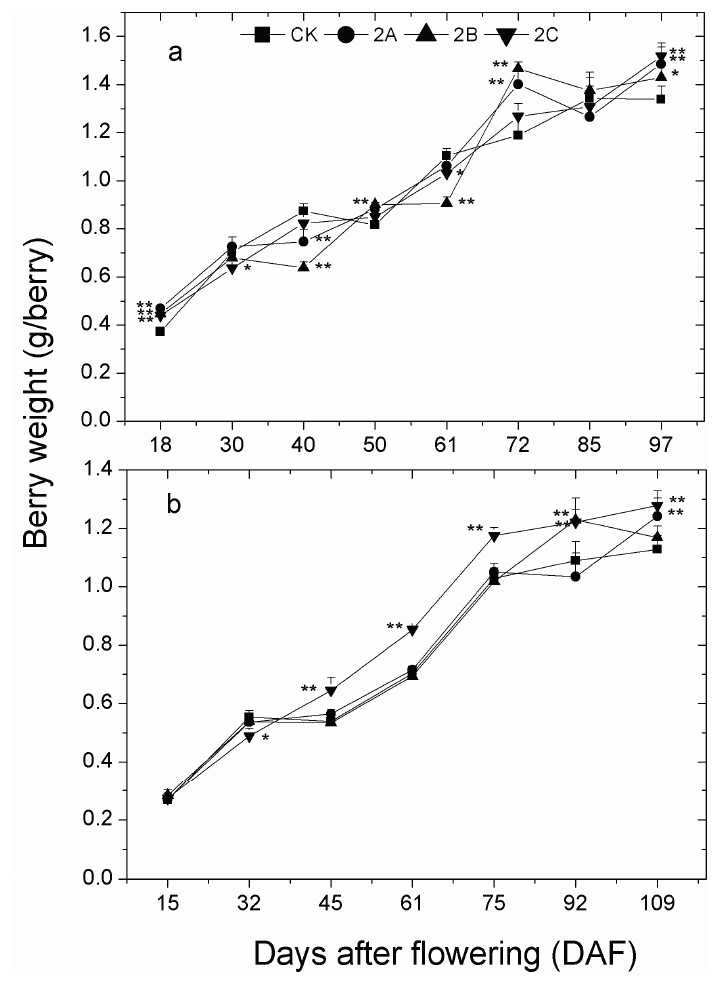
Figure 2. The change of berry weight with developmental stages in 2013 ( a ) and 2014 ( b ). Veraison stage corresponds to 61 DAF in both years, the same in the following figures. The symbols and bars indicate the mean of three values and their standard deviation. The asterisk represents the weight of berries in the zinc treatment group is significantly different than the control group at 1% level (for two asterisks) and 5% level (for one asterisk), respectively. Table 2. The total soluble solids (°Brix) of developing berries in 2013 and 2014.